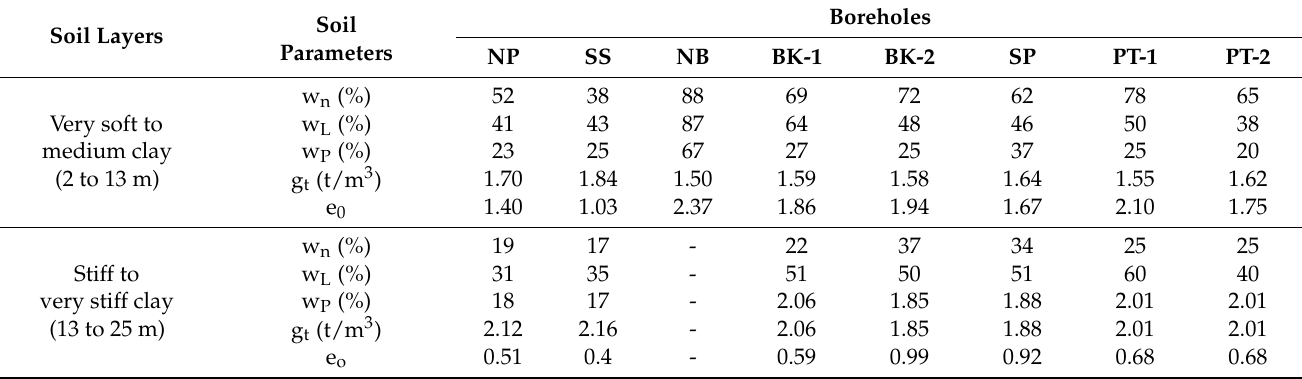
Table 3. Soil parameters for